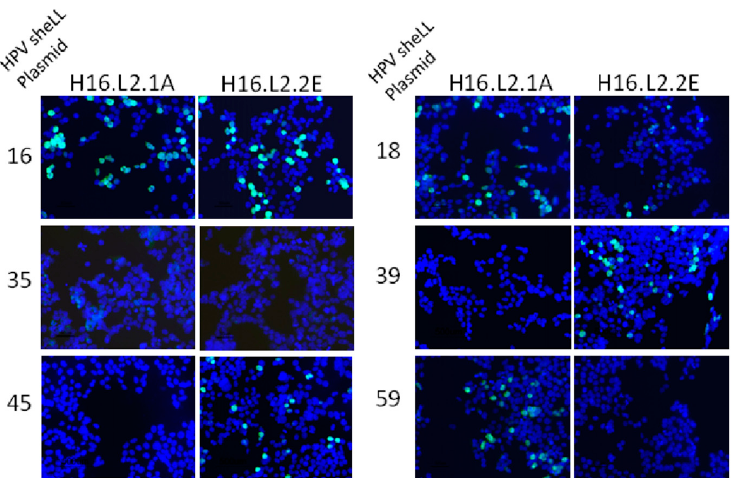
Figure 3. Immunofluorescence detection of anti-L2 mAb binding to L2 protein expressed in 293TT cells. Cells were transfected with sheLL plasmids for HPV16, 18, 35, 39, 45, 59 and fixed/permeabilized 48 h later. Anti-L2 mAbs were added to the cells and recognition of the L2 protein was detected with a goat anti-mouse immunoglobulin G (IgG) secondary antibody conjugated to Alexafluor